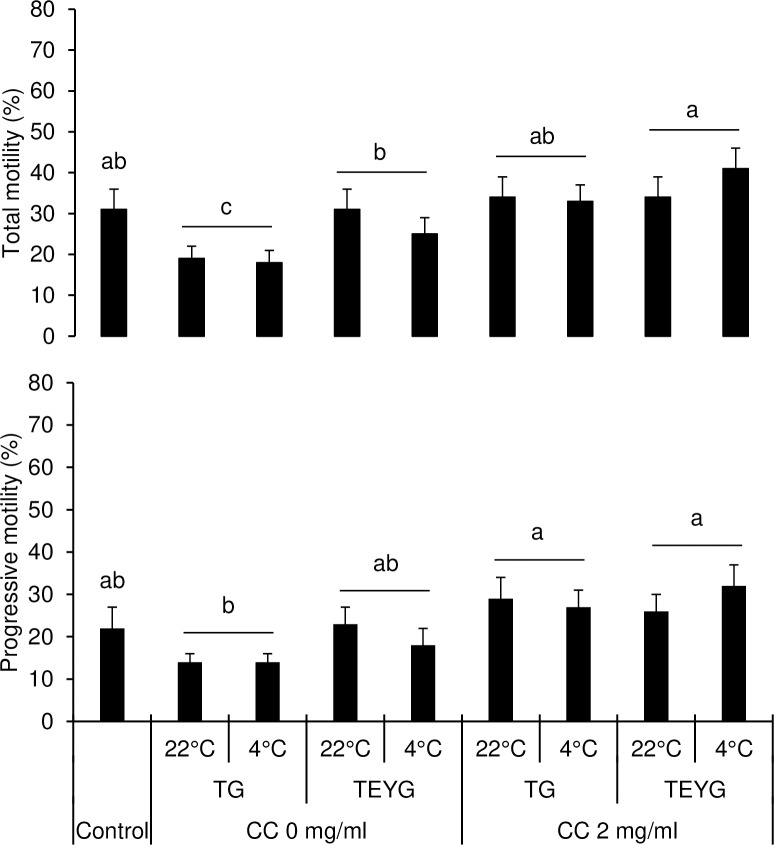
Effect of cholesterol-cyclodextrin complex, extender and temperature of glycerol addition on post-thaw sperm total motility and progressive motility.Each bar represents mean±SEM of five pooled ejaculates (replicates) from four bulls. Within a motility characteristic, bars with different letters (a-c) differ from each other (p < 0.05). Abbreviations: CC, cholesterol-cyclodextrin complex; EY, egg yolk; TG, tris-glycerol extender; TEYG, tris-egg yolk-glycerol extender.